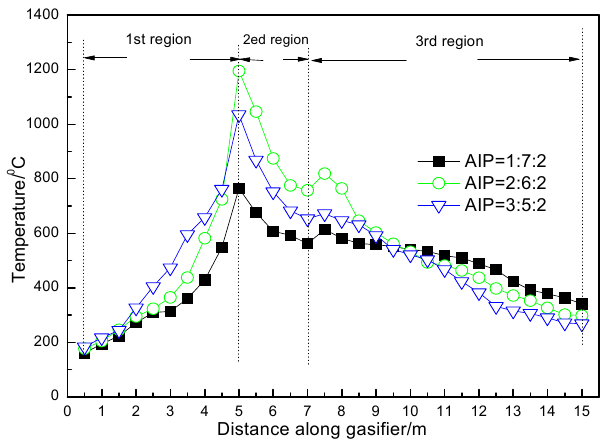
Figure 5. Temperature profile varied with AIP.